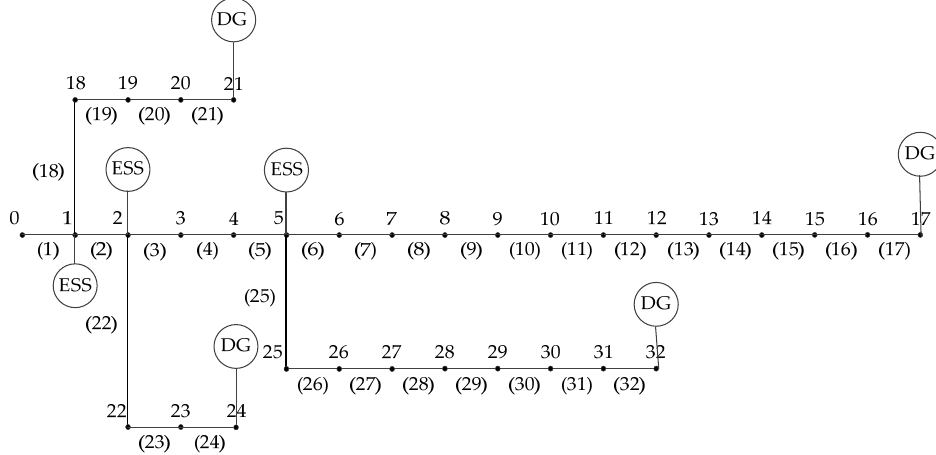
Figure 4. Example of the IEEE-33 node system.